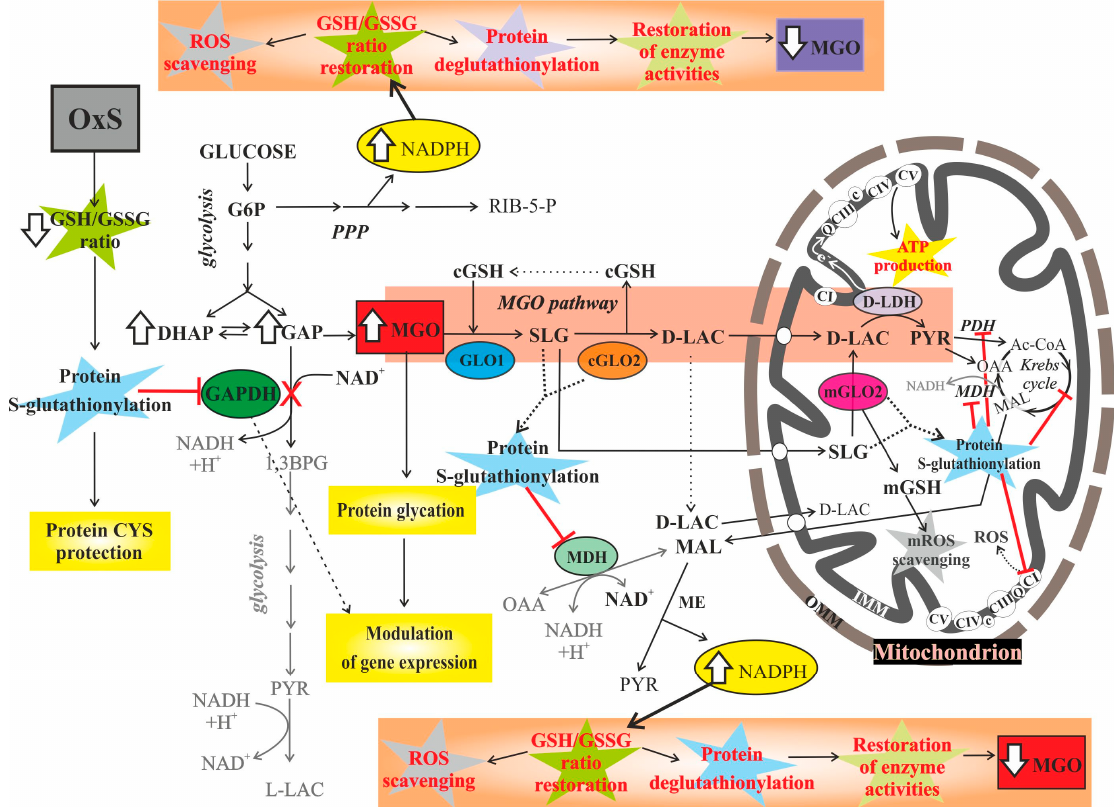
Figure 1. The role of methylglyoxal and methylglyoxal pathway in cell response to oxidative stress. The possible role of MGO and MGO pathway in cell response to OxS are schematically represented. OxS is shown to cause the elevation of MGO level as a result of OxS-induced S-glutathionylation and inhibition of GAPDH. In the presence of non-limiting amounts of cGSH, MGO can feed the MGO pathway, leading to increased SLG and D-LAC formation which can both facilitate the res-toration of the normal redox state. The possible role of MGO as a signaling molecule, through protein modification and gene expression modulation, is also represented. SLG can feed the mGSH pool via mGLO2 reaction, thus contributing to mitochondrial reactive oxygen species (mROS) scavenging. D-LAC oxidation, catalyzed by the mitochondrial flavoprotein D-lactate de-hydrogenase (D-LDH), can sustain mitochondrial ATP production, bypassing the ROS-producing complex I (CI) of the respiratory chain. D-LAC can also cause the efflux of malate (MAL) from mitochondria, thus contributing to NADPH synthesis and ROS detoxification in the cytosol. The role of OxS-induced S-glutathionylation, to which GLO2 and SLG can contribute, in the inhibition of certain cytosolic and mitochondrial enzymes, and protection of protein cysteine residues (CYS) from irreversible deactivation, is also highlighted. The white-filled arrows indicate the enhance-ment/decrease of metabolite levels caused by, or in response to OxS. Grey writings and arrows in-dicate decreased metabolite levels/reactions due to OxS-activated S-glutathionylations. Abbrevia-tions not included in the text: Ac-CoA, acetyl CoA; 1,3BPG, 1,3-bisphosphoglycerate; CIII, coen-zyme Q—cytochrome c reductase (complex III); CIV, cytochrome c oxidase (complex IV); CV, ATP synthase (complex V); Q, coenzyme Q; c, cytochrome c; CYS, cysteine residues; G6P, glucose-6-phosphate; ME, malic enzyme; OAA, oxaloacetate; PYR, pyruvate; RIB-5-P,